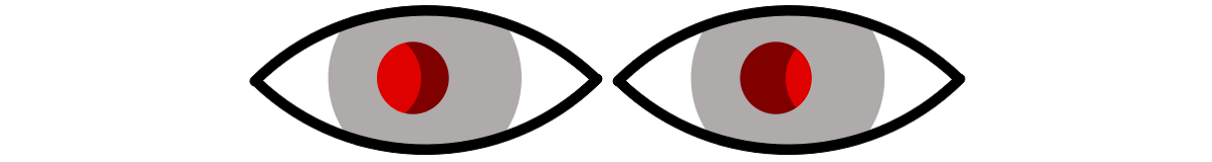
Figure 4. Typical red reflex pattern, with flash on the left. Left: Myopia. Right: